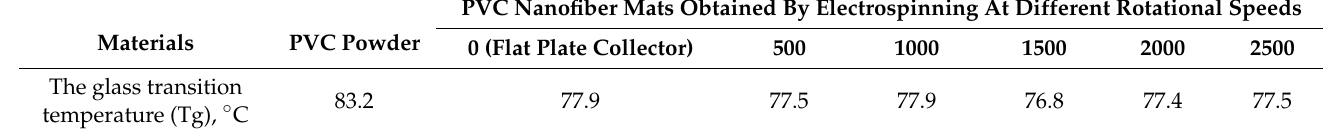
Table 4. Glass transition temperature (Tg) of PVC nanofibers and PVC